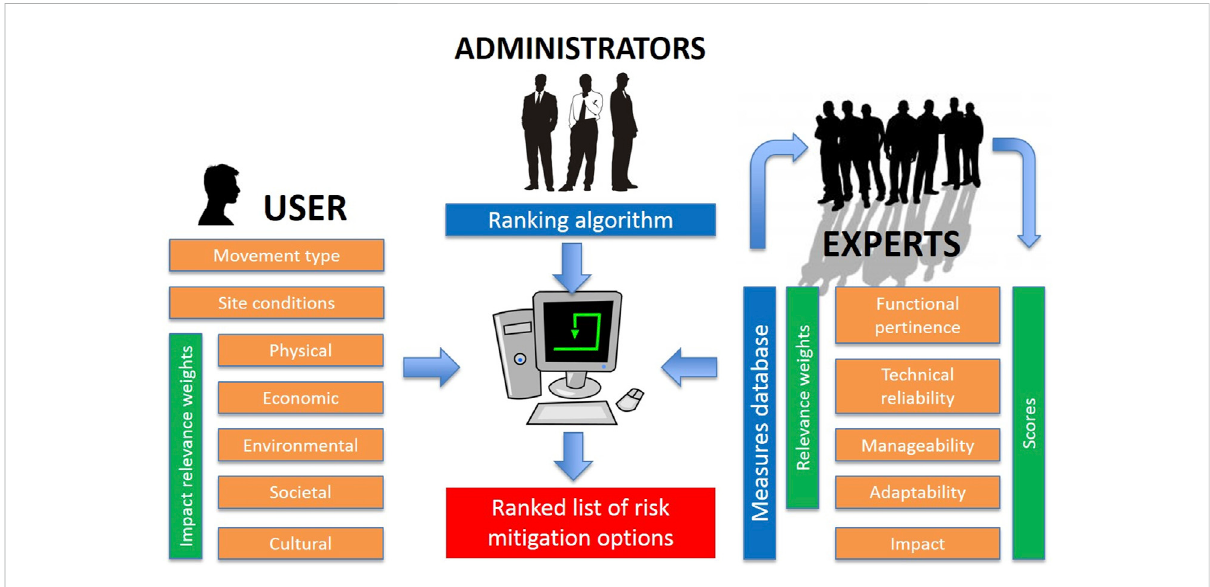
Schematic representation of the synergy between administrators, experts and users in the compilation and utilization of the LaRiMiT toolbox.